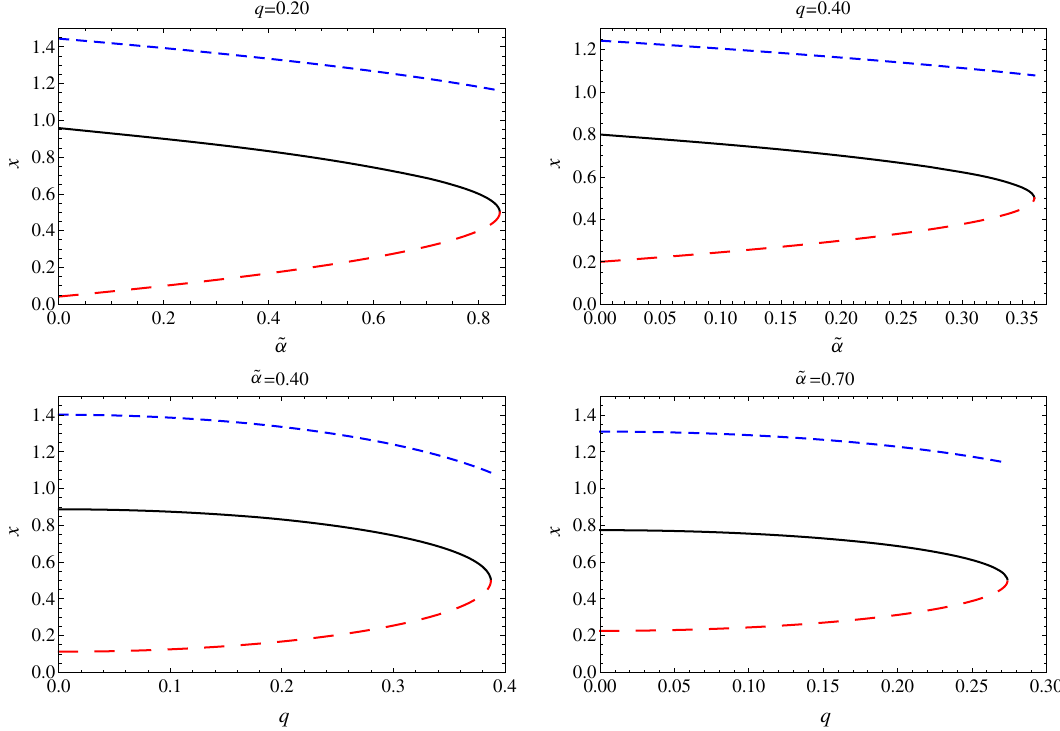
Fig. 3 The behavior of event horizon radii x + (solid black line), Cauchy horizon radii x − (dashed red line), and photon sphere radii x m (dashed blue line) with ˜ α and